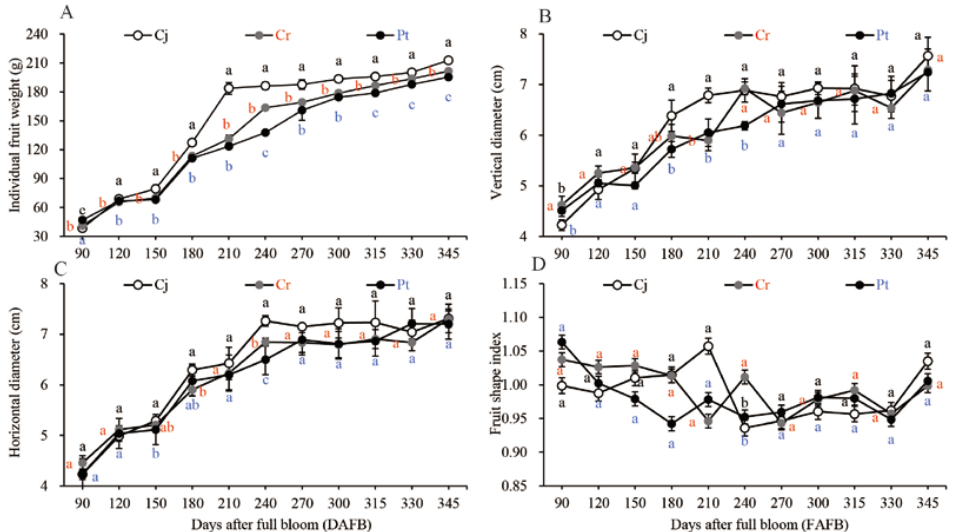
Figure 2. Dynamic changes in the physical properties of blood oranges grafted onto different rootstocks during fruit development and ripening. ( A ) Individual fruit weight. ( B ) Vertical diameter. ( C ) Transverse diameter. ( D ) Fruit shape index. Means and standard deviations were calculated from three independent biological replicates. Means with different lower-case letters are significantly different. The statistical significance was set at p < 0.05. Vertical bars indicate standard deviations of means. The same applies below.